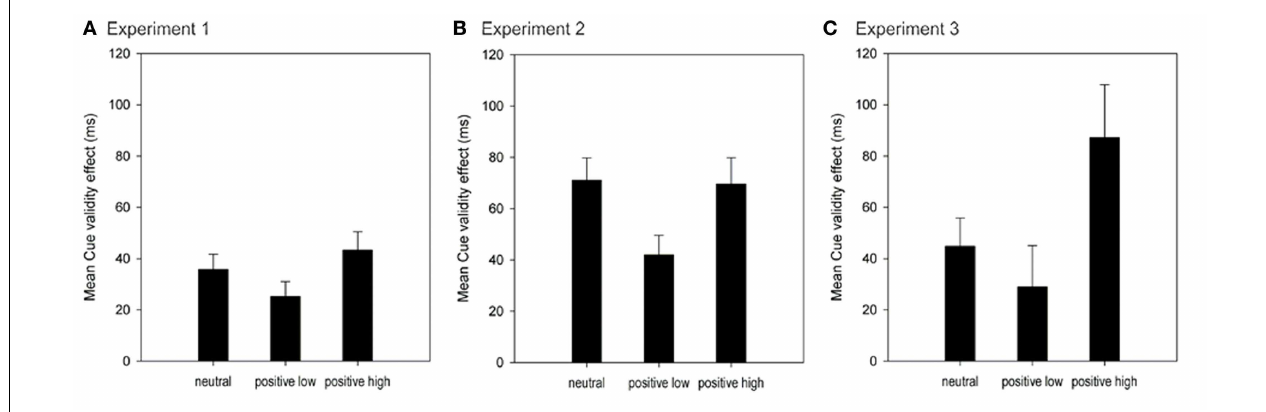
FIGURE 4 | Mean Cue validity effects (in ms) as a function ofAffect group for Experiment 1 (A), Experiment 2 (B), and Experiment 3 (C). Error bars represent 1 standard error of the